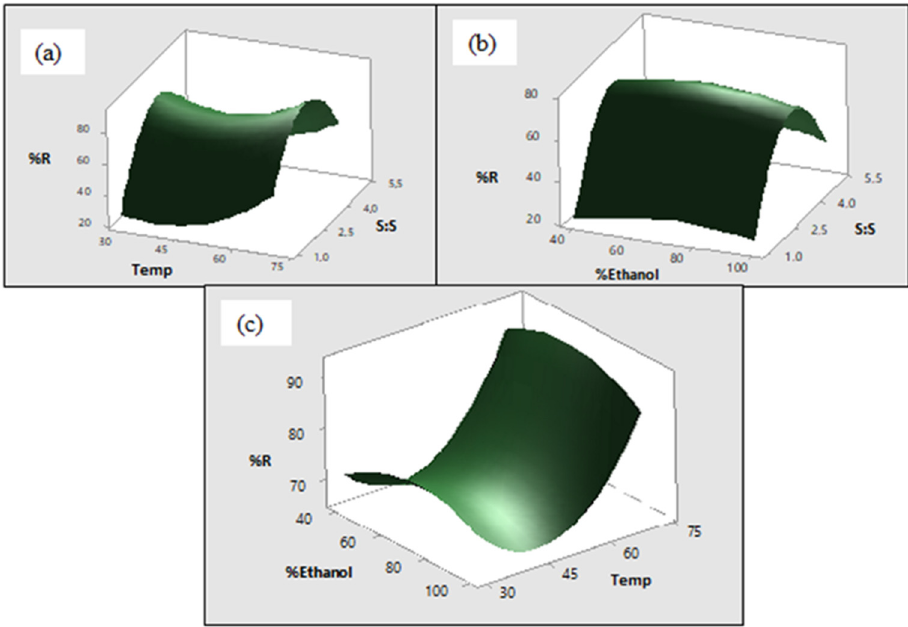
Figure 2. Surface and contour plots showing percentage recovery as function of the effects temper- ature and solvent ratio (S:S) while keeping percentage ethanol constant ( a ); effects of percentage ethanol and solvent ratio (S:S) while keeping temperature constant ( b ); and effects of percentage ethanol and temperature while keeping solvent ratio constant ( c ).